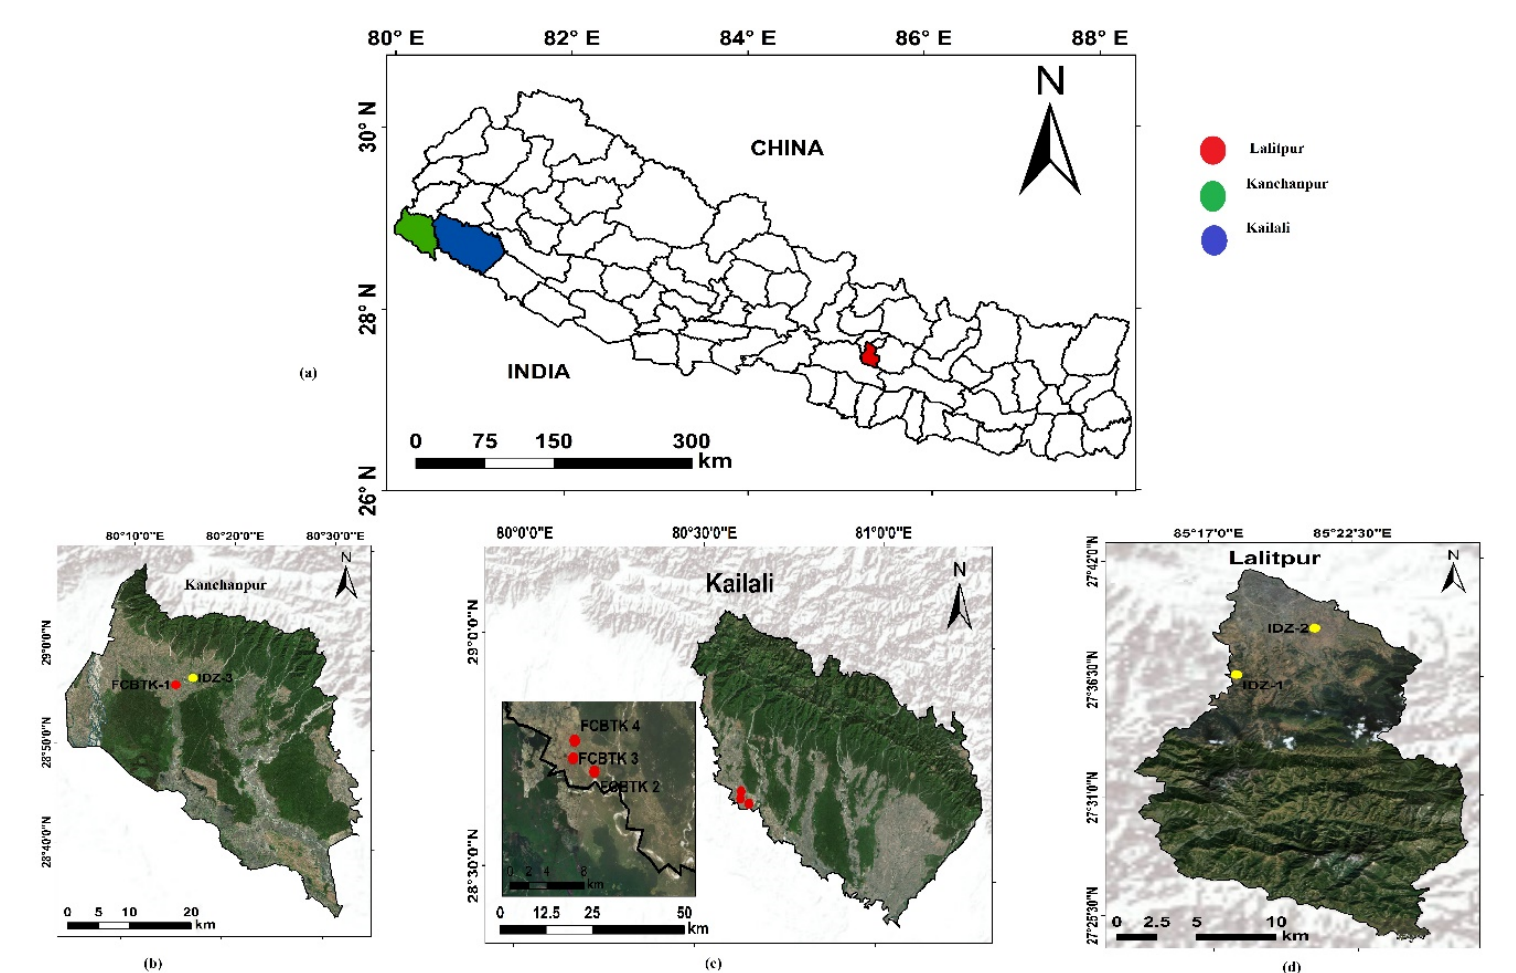
Figure 1. Study location: ( a ) map of Nepal indicating Kanchanpur (green patch), Kailali (blue patch), and Lalitpur districts (red patch); ( b ) expanded view of Kanchanpur district; ( c ) expanded view of Kailali district; and ( d ) expanded view of Lalitpur district, with dots representing the location of kilns. The red dots denote FCBTKs (fixed chimney bull’s trench kilns) and yellow dots indicate IDZKs (induced-draught zigzag kilns) measured during the study.